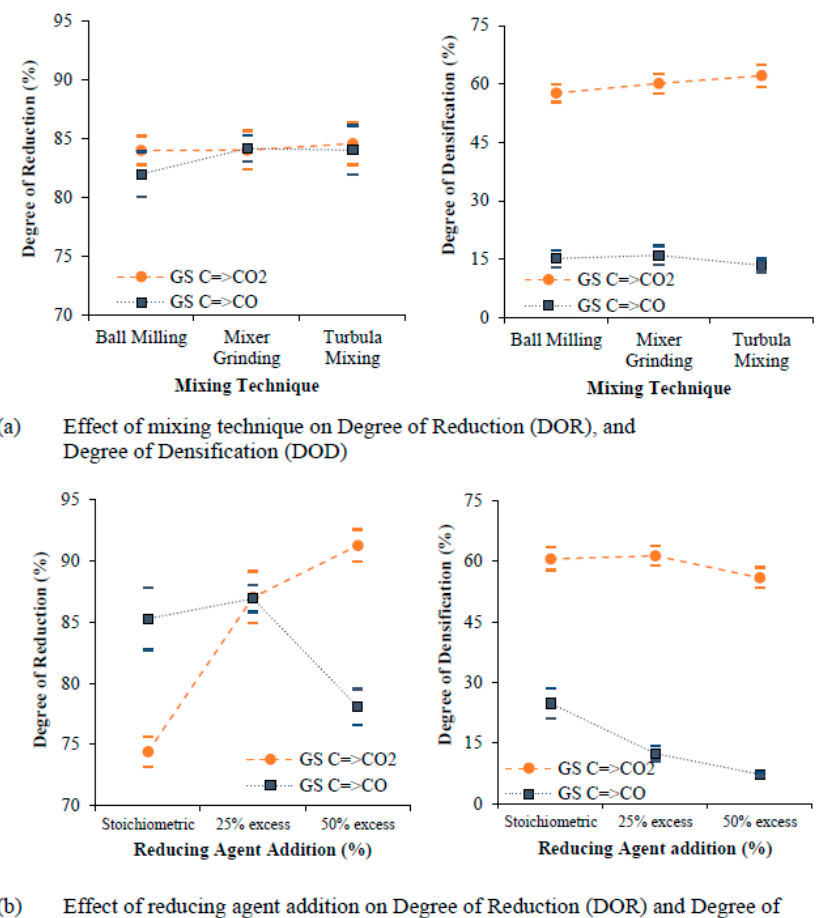
Figure 8. The main effects of ( a ) mixing technique and ( b ) the addition of reducing agent on the degree of reduction (DOR) and degree of densification (DOD) for the grinding